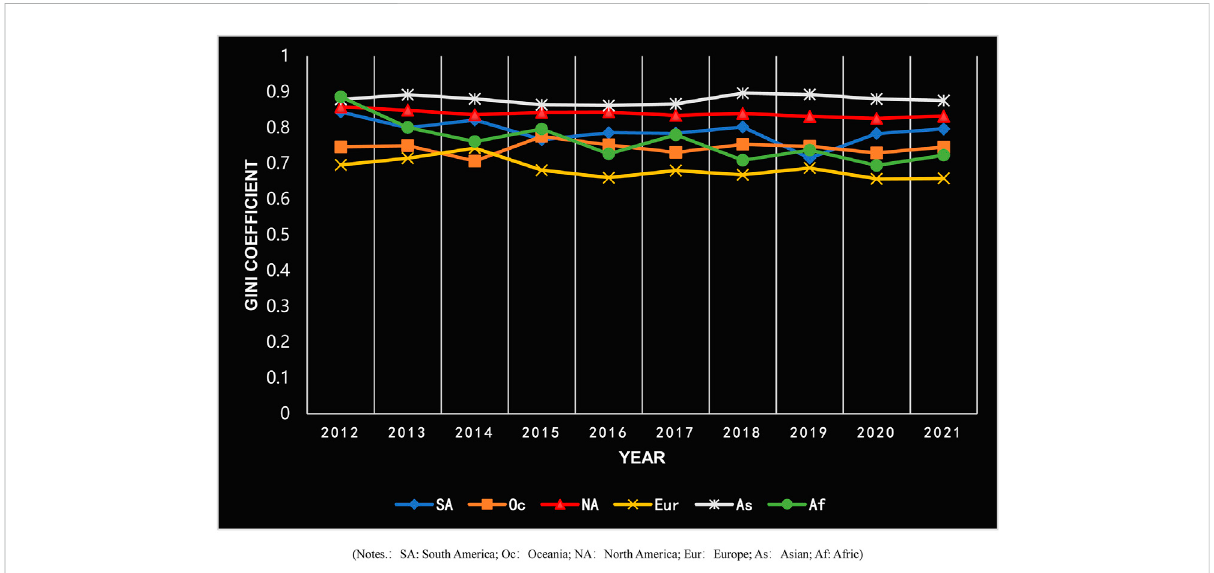
FIGURE 4 Evolution of the intracontinental variation in the output of remote sensing research. (Notes.: SA: South America; Oc: Oceania; NA: North America; Eur: Europe; As: Asian; Af: